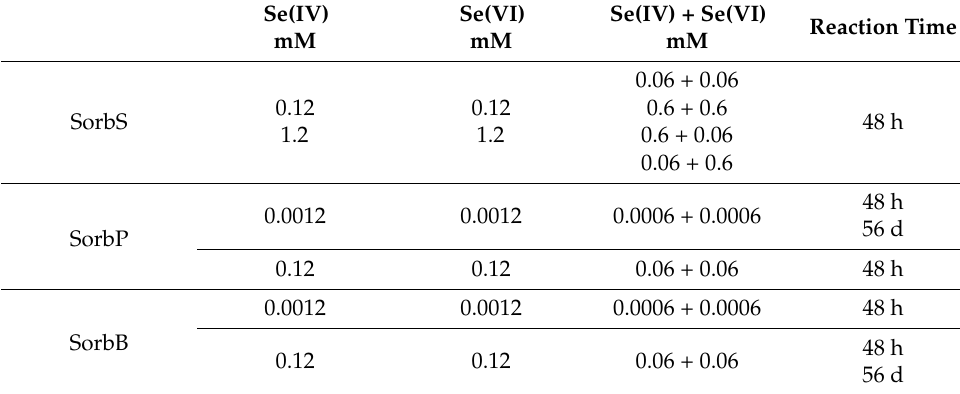
Table 1. Experimental conditions for XAS